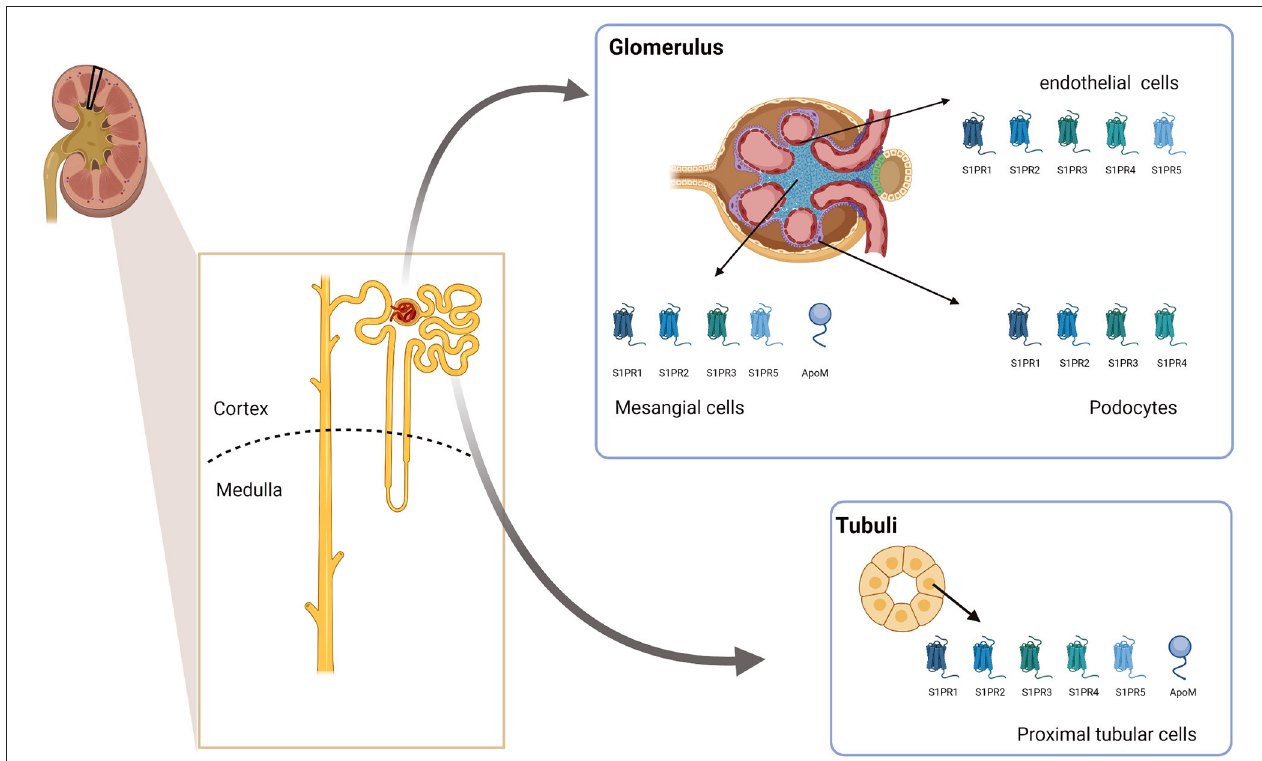
FIGURE 1 | ApoM and S1PR expression in the kidney. The schematic figure summarizes the current knowledge on which cell types in the kidney express apoM and different S1PRs. Created with BioRender.com. ApoM, apolipoprotein M; S1PR1-5, Sphingosine-1-phosphat receptor